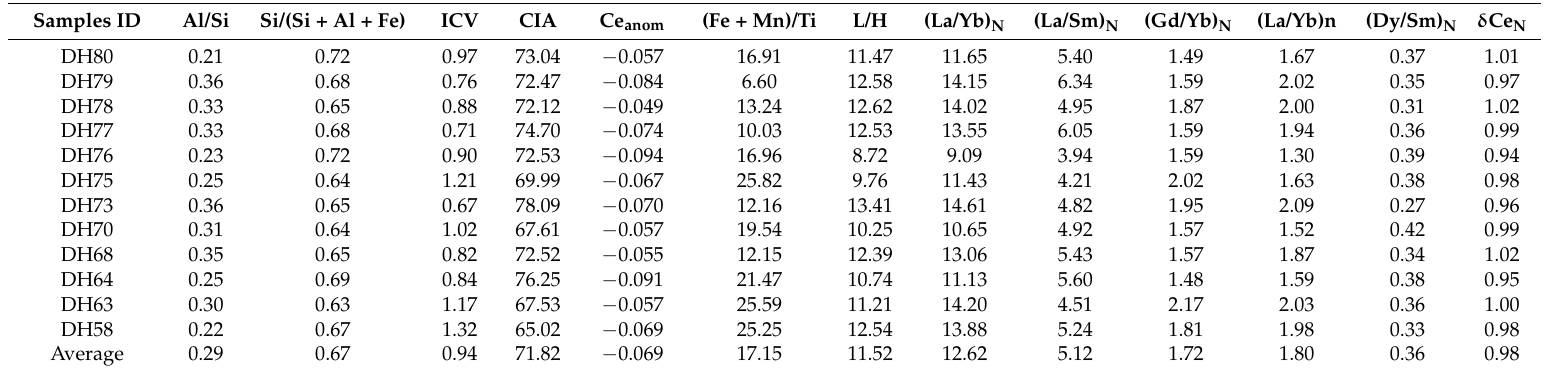
Table 3. Geochemical parameters of oil shale